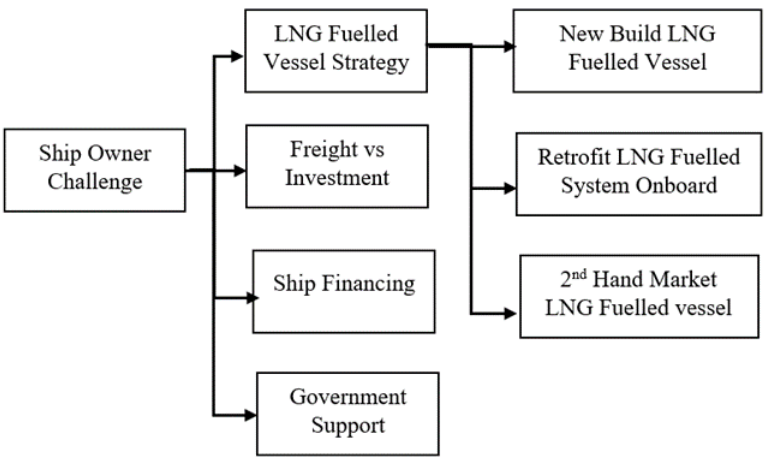
Figure 5. Indonesian vessel owners challenging condition.